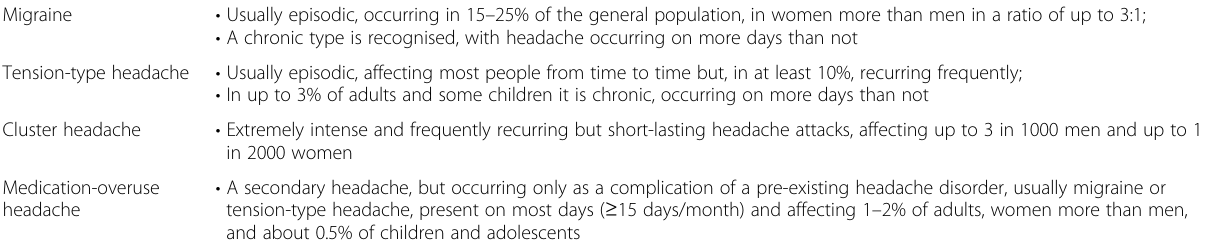
Table 1 The headache disorders of particular importance in primary care Migraine Tension-type